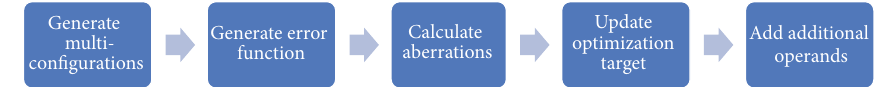
Figure 10: Aberration subtraction method for athermalization.